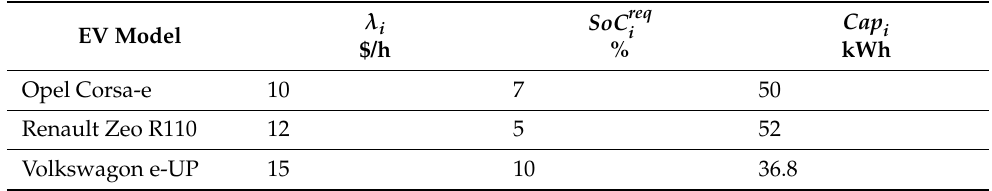
Table 1. Consumers initial data.